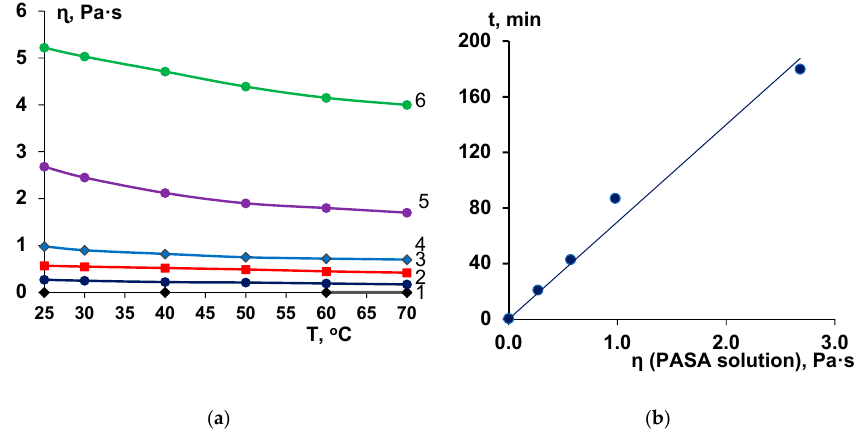
Figure 3. Dependence of the dynamic viscosity of the aqueous solutions of PASA at different concentrations (in wt %: 1—0; 2—0.05; 3—0.1; 4—0.2; 5—0.3; 6—0.5) on temperature ( a ) and correlation of membrane formation time at T = 25 ××°C with viscosity of PASA solutions ( b ).